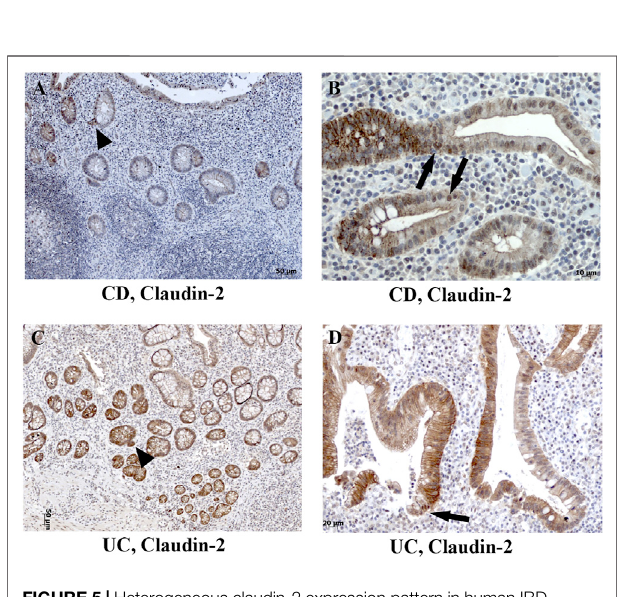
FIGURE 5 | Heterogeneous claudin-2 expression pattern in human IBD colon tissue. (A) Claudin-2 (IHC) positive cells at sites of “ crypt budding, ” CD; (B) claudin-2(IHC)expressedalongcellmembranesandwithinnuclei,CD; (C) claudin-2 (IHC) positive cells at sites of “ crypt budding, ” UC; (D) claudin- 2 (IHC) expressed along membranes and within nuclei, UC. Highlighted features: “ crypt budding ” (arrowheads) and claudin-2 positive nuclei (arrows). CD, Crohn disease; UC, ulcerative colitis.